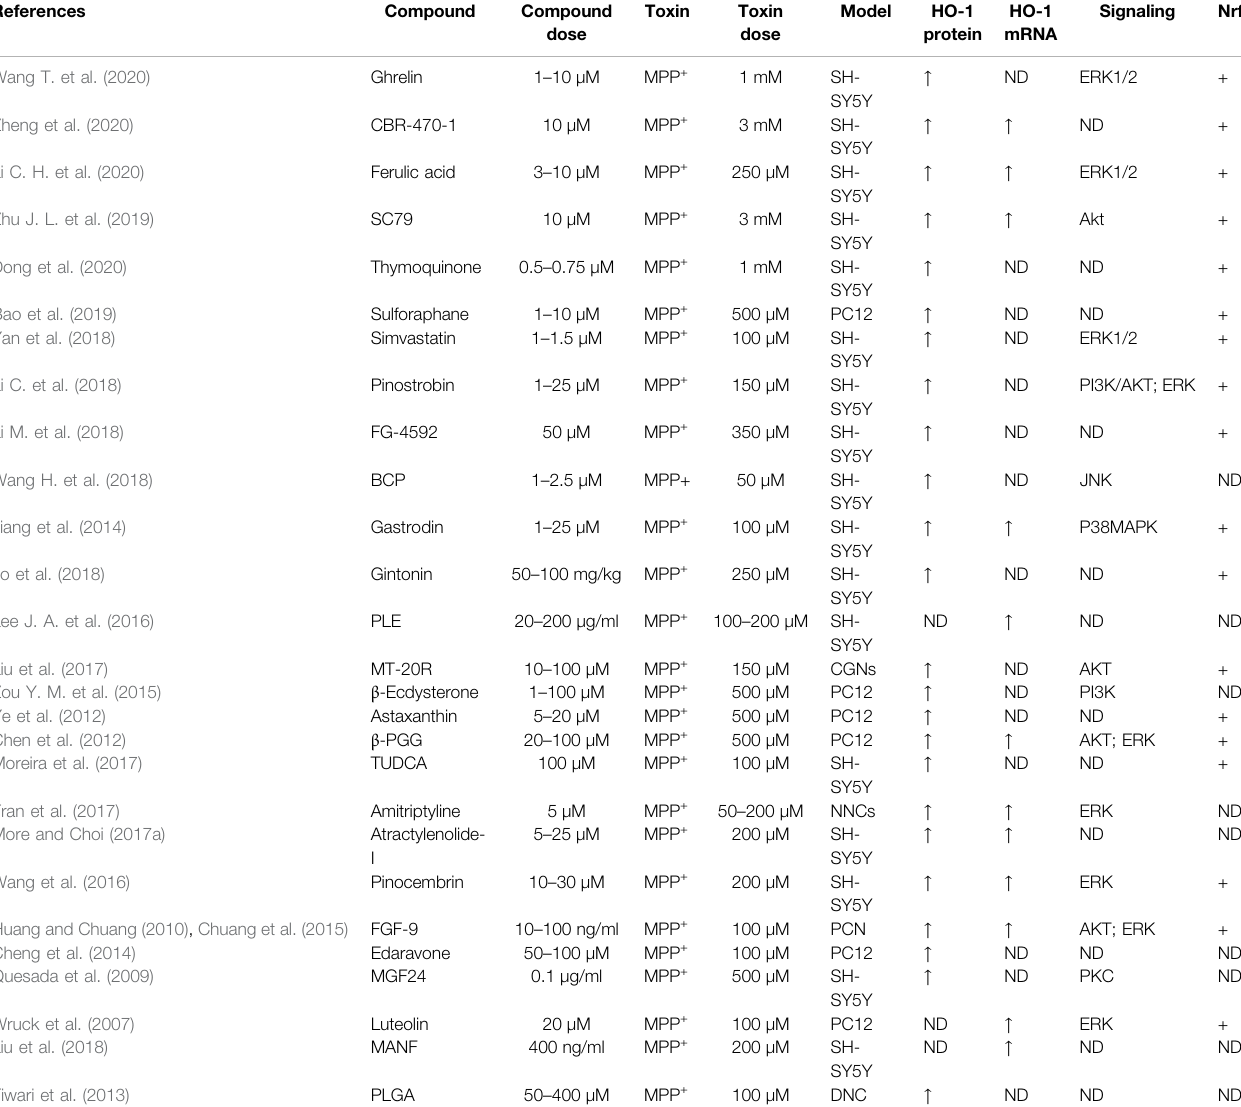
TABLE 8 | Summary of the experimental studies involving HO-1 inducer against MPP + -induced PD